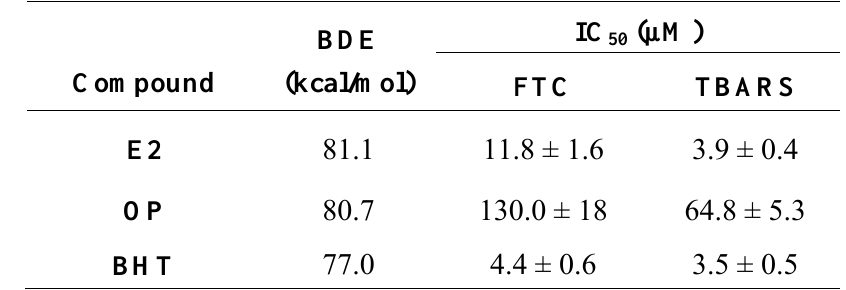
Table 1. Calculated BDE of the phenolic O–H and a cell-free LPO inhibitory potency of E2, OP and BHT,